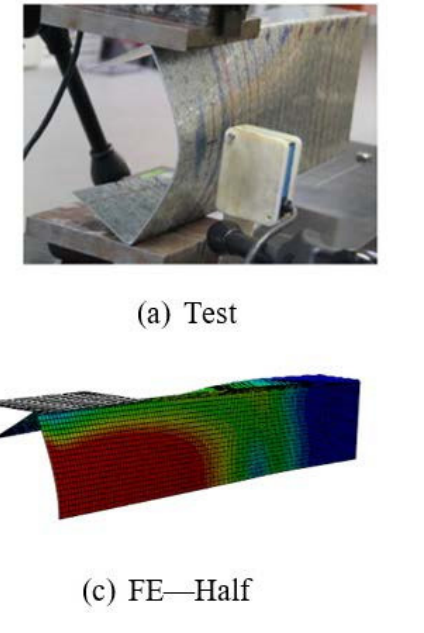
Figure 14. Failure mode comparison for full and half models of ETF-UC20015 with 150 mm bearing plate [21].